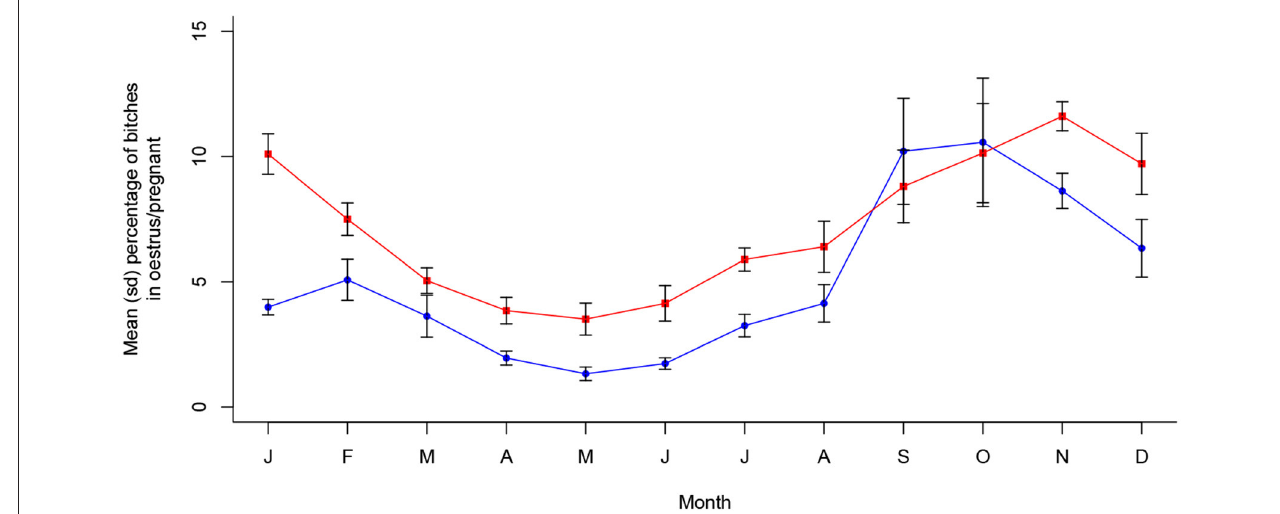
FIGURE 4 | Mean (sd) proportions of bitches in oestrus and pregnant in Dehradun, India between 2016 and 2021 ( n =